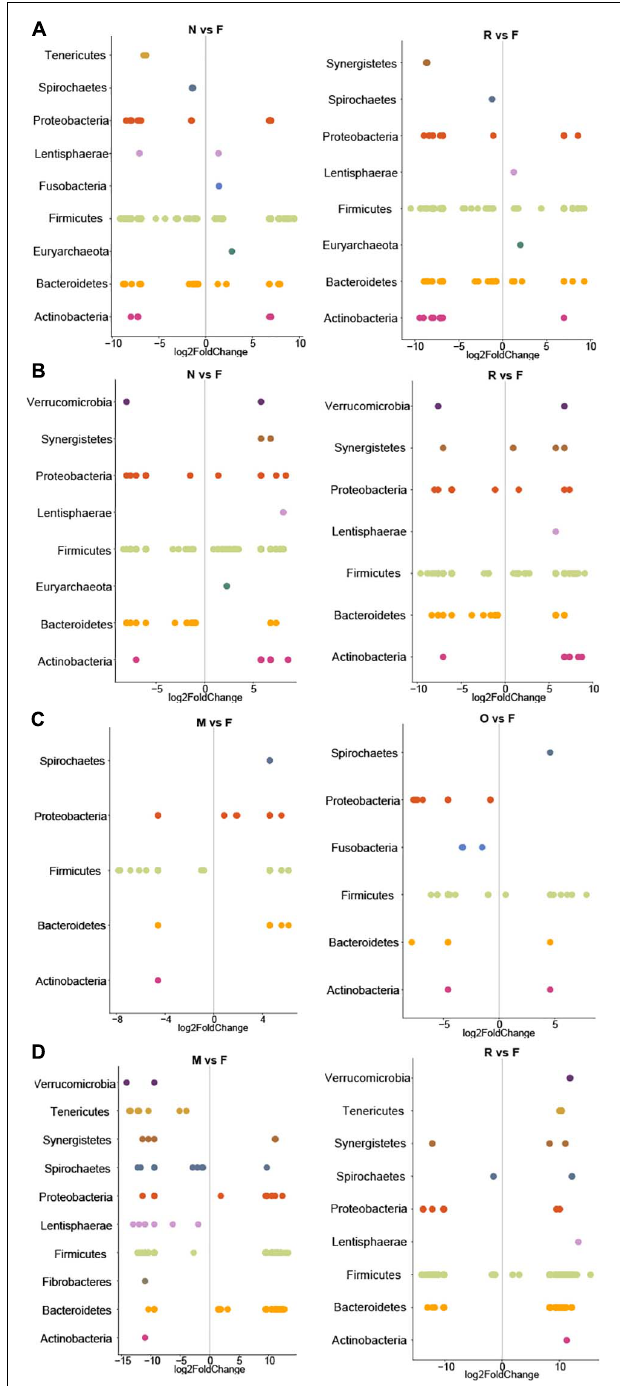
FIGURE 10 | Impact of extraction method on differential abundances of microbiota. Significant ( q < 0.05) log-fold changes in the abundances of microbial phyla in samples stored at − 80 ◦ C or in different storage buffers for chicken cecum (A) , chicken feces (B) , pig ileum (C) , and pig feces samples (D) . Positive log-fold change indicates an increase in abundance, while negative log-fold change indicates a reduction in abundance over time compared to the freshly extracted samples group in chicken cecum,